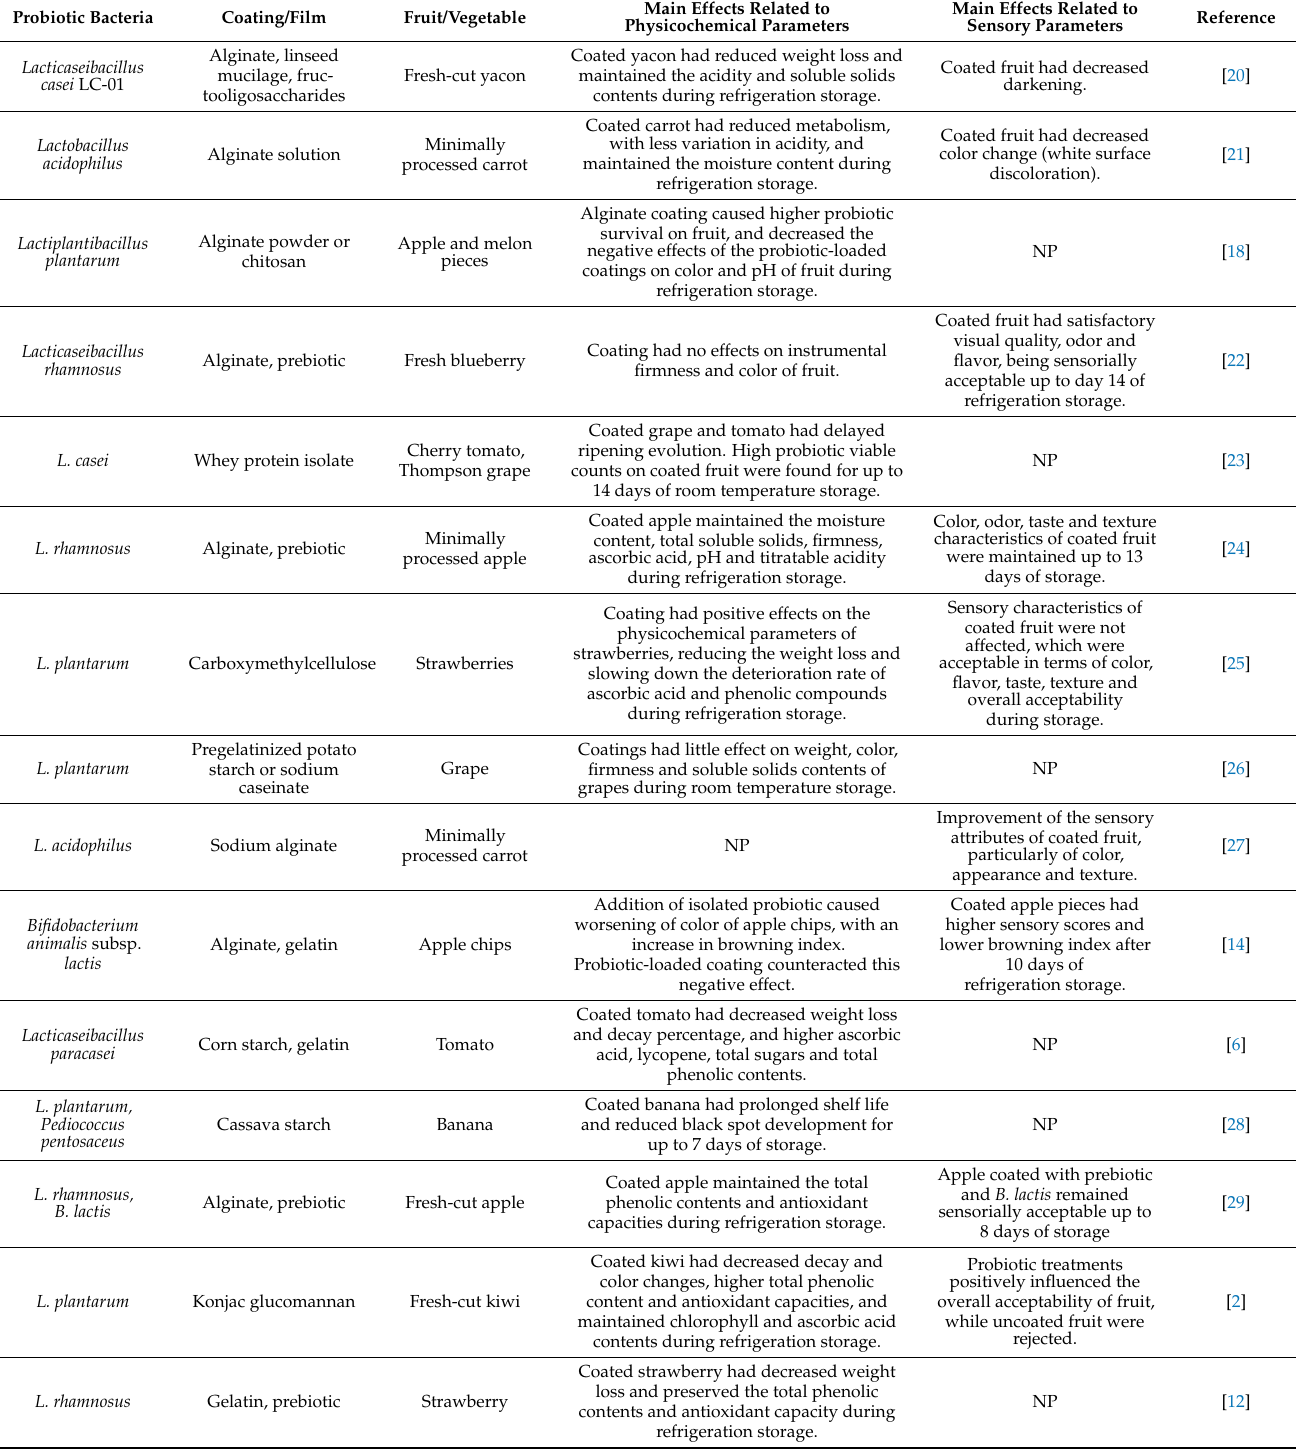
Table 4. Effects of the application of probiotic-loaded edible films/coatings on quality (physicochemical and/or sensory) parameters of fruit and